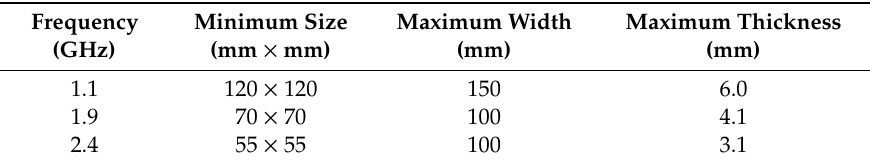
Figure 2. Complete SPDR measurement system. Table 1. The minimum size, maximum width, and thickness of MUT according to the operating frequency of SPDR [32].